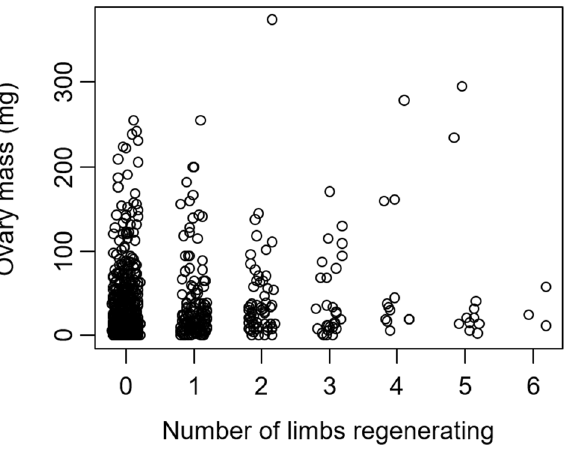
Figure 4. Ovary mass of individual gravid Hemigrapsus sanguineus of all sizes sampled in 2020 as a function of the number of missing limbs that are